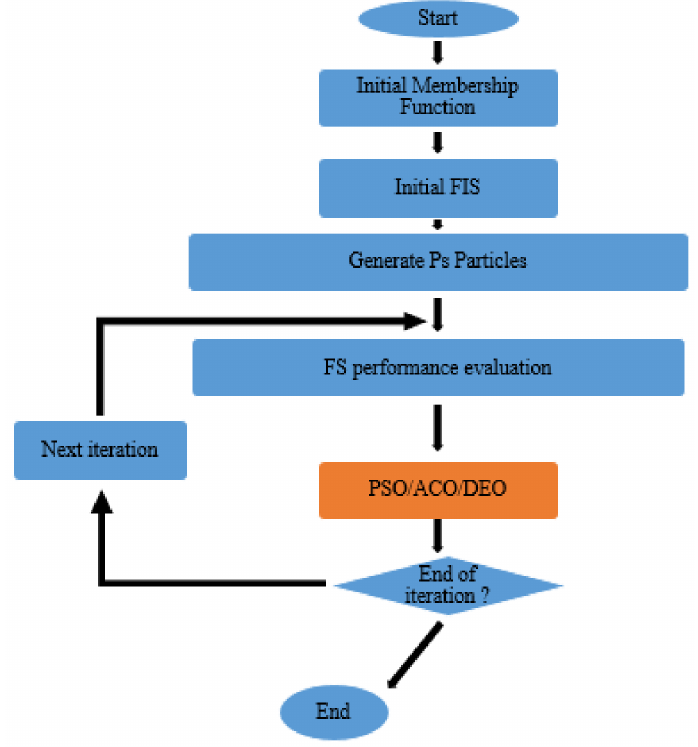
Figure 9. Diagram of the sequential combination of PSO/ACO/DEO and